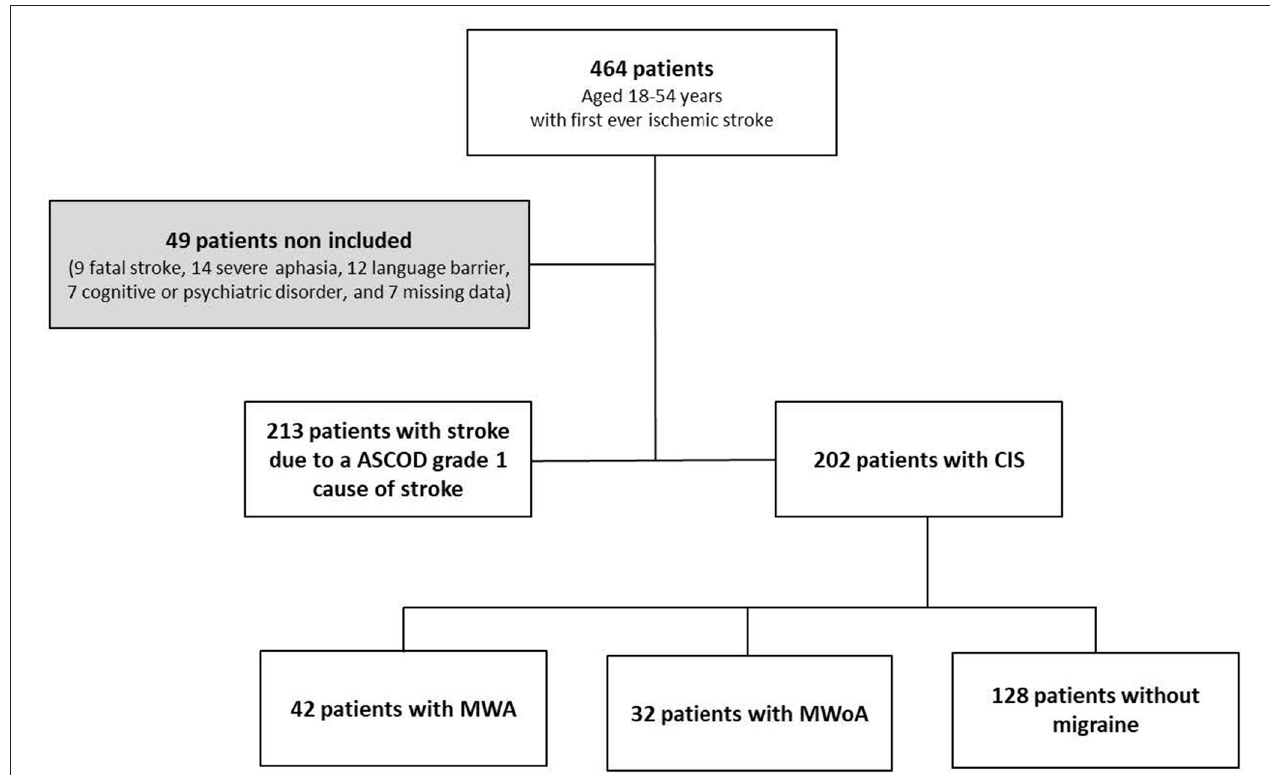
FIGURE 1 | Flow chart of the study. CIS, cryptogenic ischemic stroke; MWoA, migraine without aura; MWA, migraine with aura.